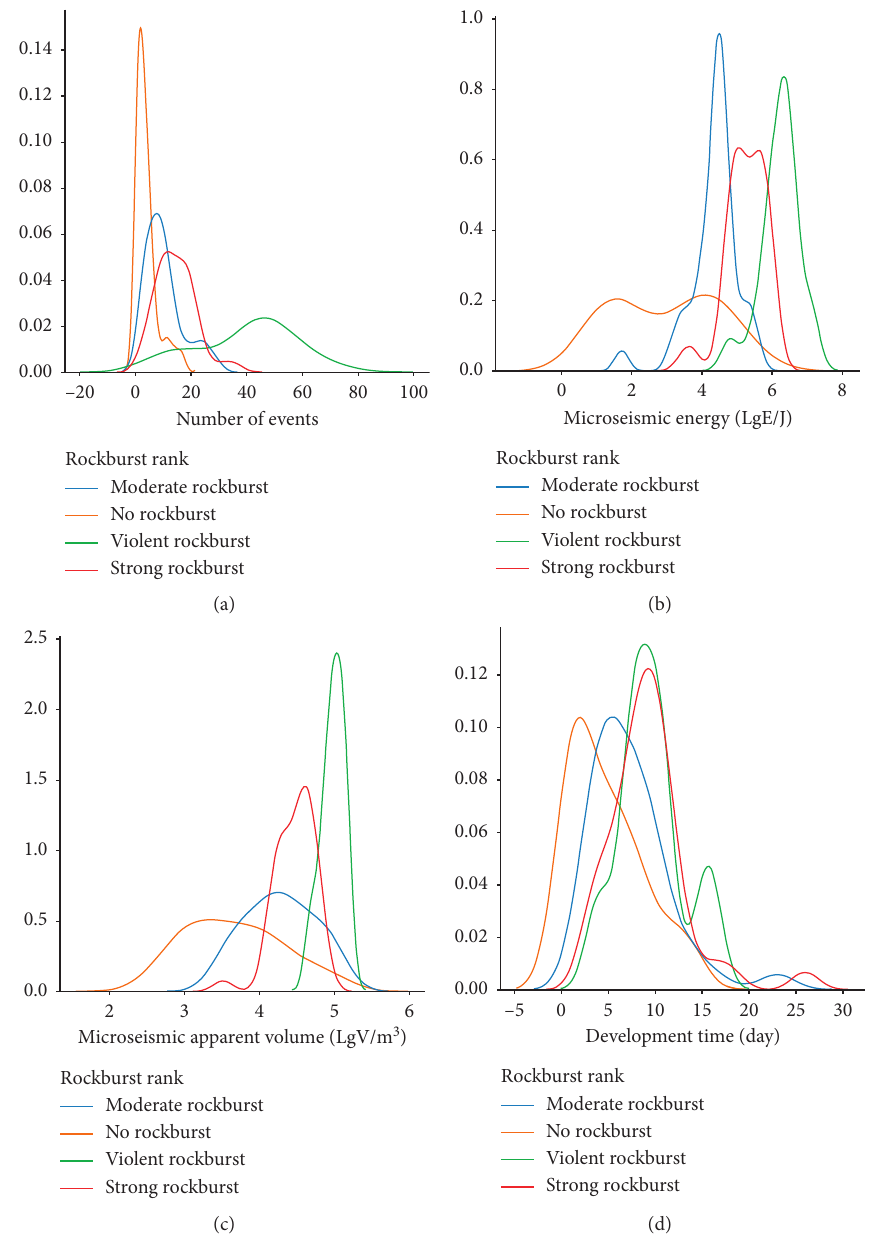
Figure 2: The relationship between rockburst rank and microseismic